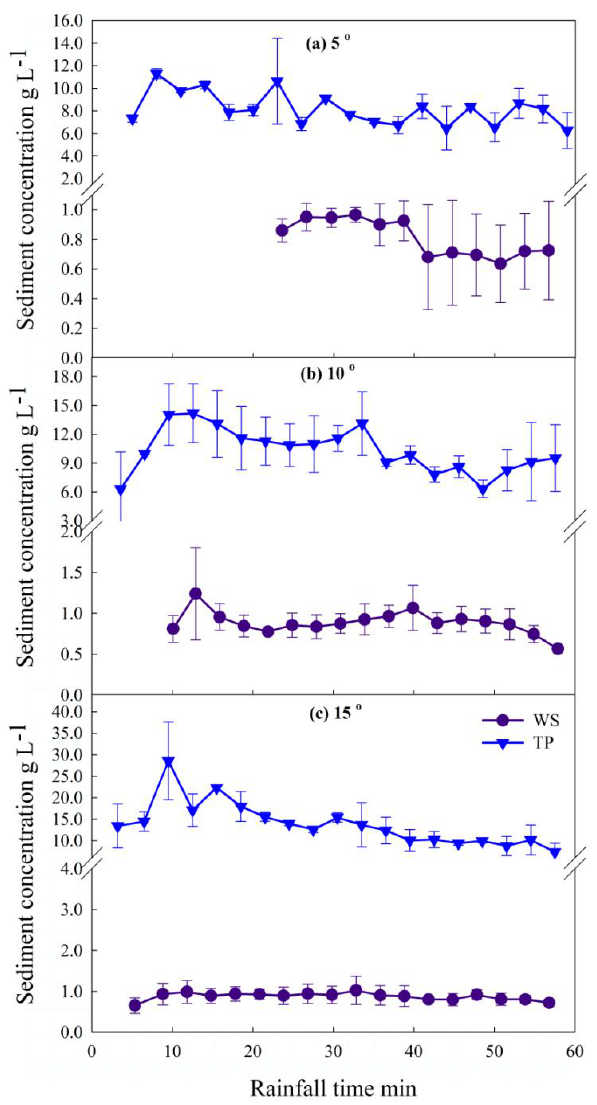
Figure 4. Dynamics of the sediment concentration in WS and TP plot during the simulated rainfall event.